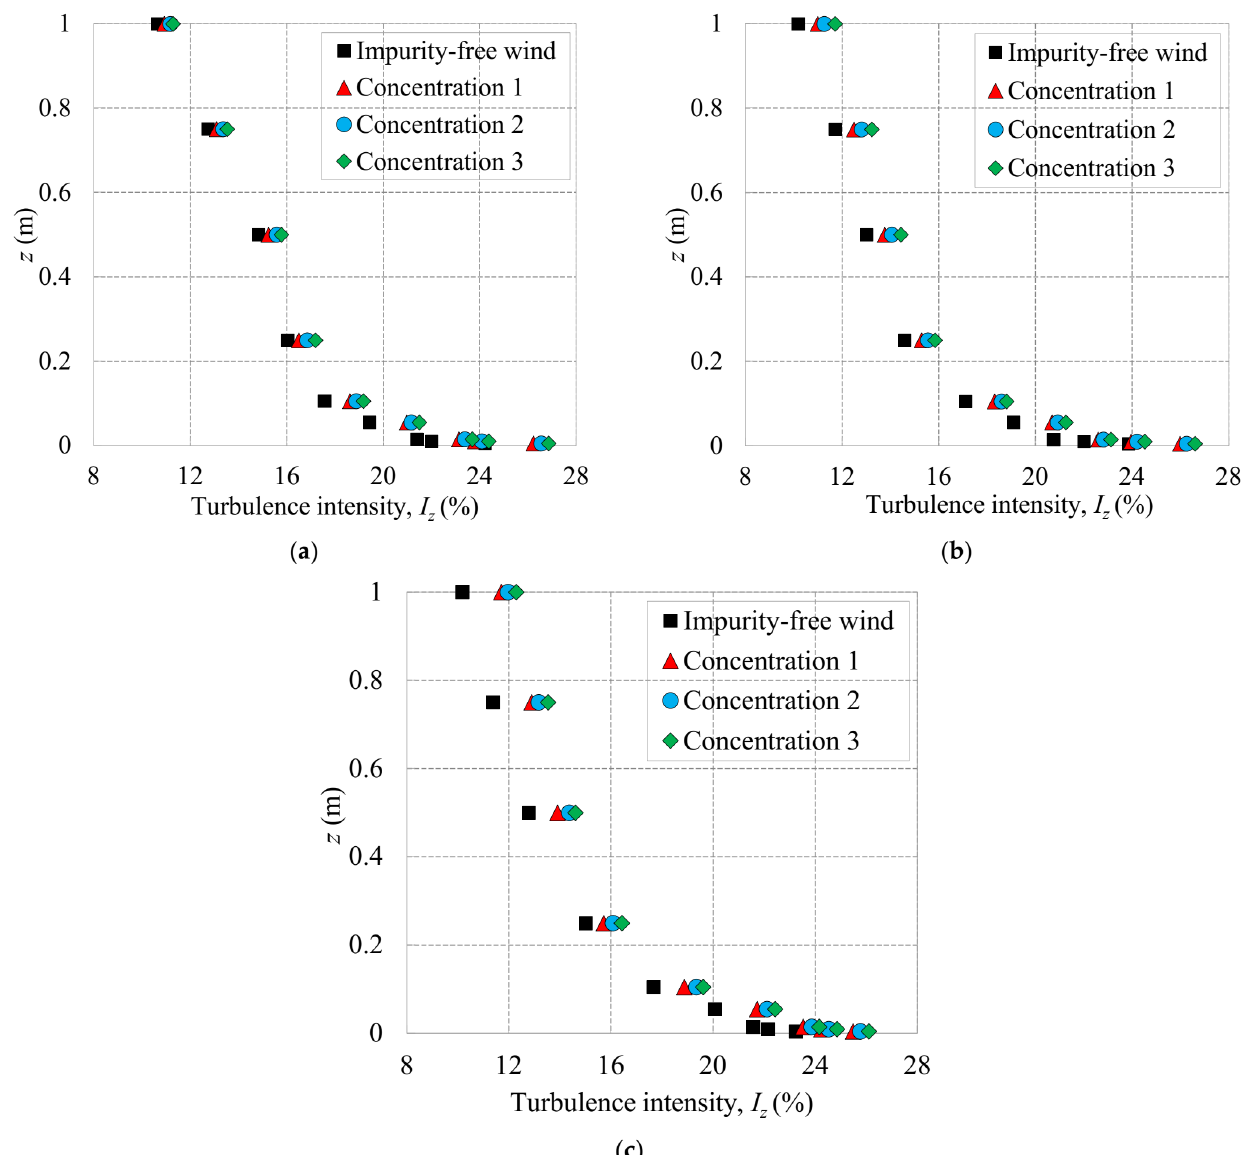
Figure 9. Turbulence intensities: ( a ) At the test wind speed of 10 m/s; ( b ) At the test wind speed of 13 m/s; ( c ) At the test wind speed of 16